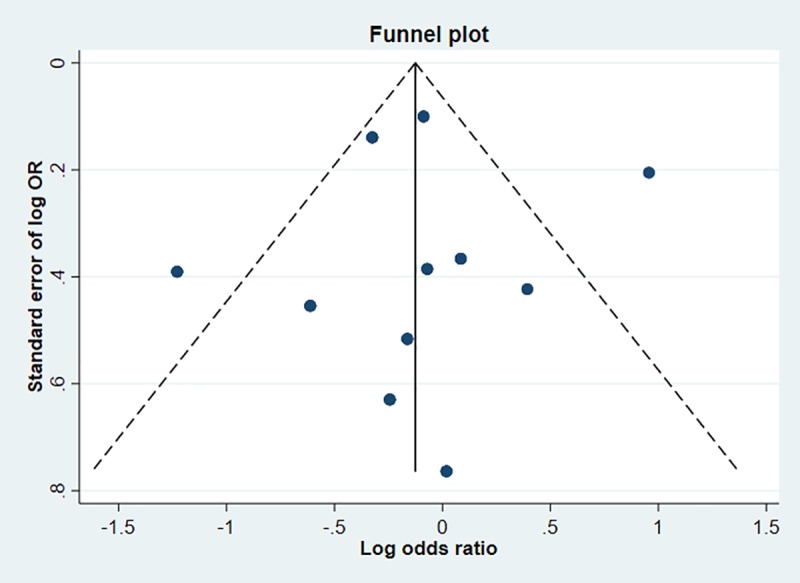
Meta-analysis of risk of community acquired pneumonia in current smokers relative to never smokers (Odds Ratio).* Study by Baik et al. had relevant data subdivided by gender, therefore data from this study were included as two separate entities (i.e. men and women). Grey box = effect estimates from single studies. Diamond = pooled result with confidence interval. Vertical line at ‘1’ on the x-axis is the line of no effect. Weight (in %) = influence an individual study had on the pooled result.